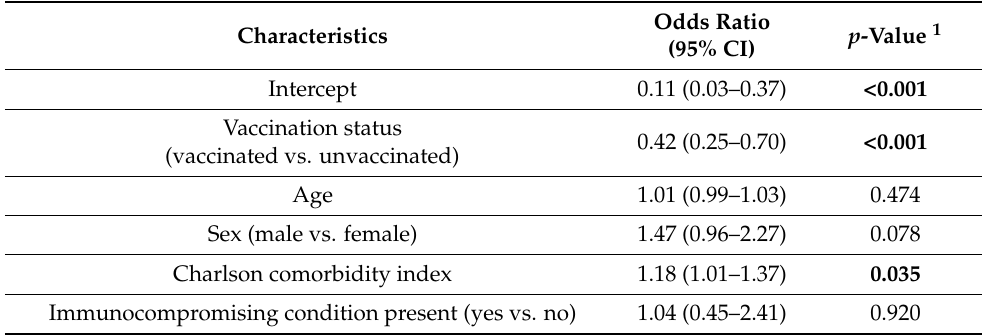
Table 2. Association between prior vaccination and progression to critically severe disease (the World Health Organization COVID-19 Clinical Progression Scale 7–10) [21]. Odds Ratio Characteristics p -Value 1 (95% CI) Intercept 0.11 (0.03–0.37) <0.001 Vaccination status 0.42 (0.25–0.70) <0.001 (vaccinated vs. unvaccinated) Age 1.01 (0.99–1.03) 0.474 Sex (male vs. female) 1.47 (0.96–2.27) 0.078 Charlson comorbidity index 1.18 (1.01–1.37) 0.035 Immunocompromising condition present (yes vs. no) 1.04 (0.45–2.41)